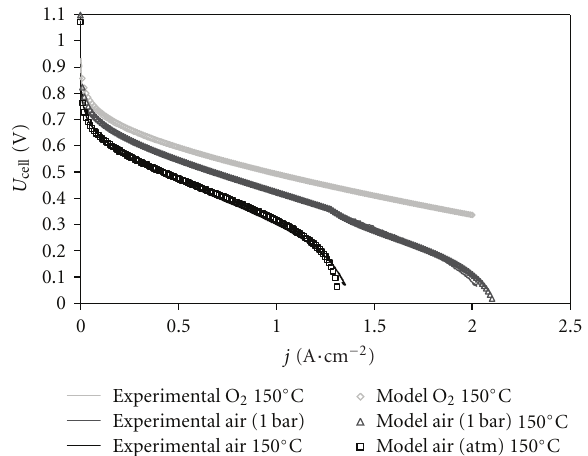
Figure 5: Comparison between modelled and experimental results for HT-PEMFC utilising 50% Pt/C at the cathode and 20% Pt/C on the anode at temperature of 150 ◦ C and various pressures; alpha value of 0.75 and γ = 1 . 375 was used for the